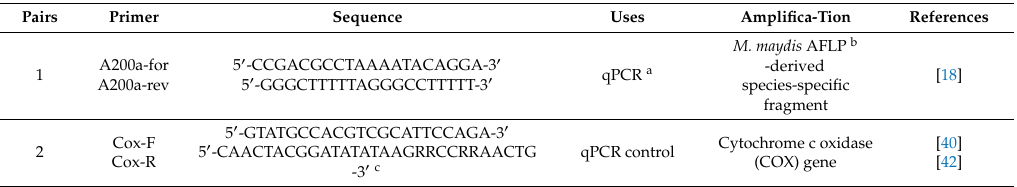
Table 4. Primers used in this study for Magnaporthiopsis maydis detection. Pairs Primer Sequence